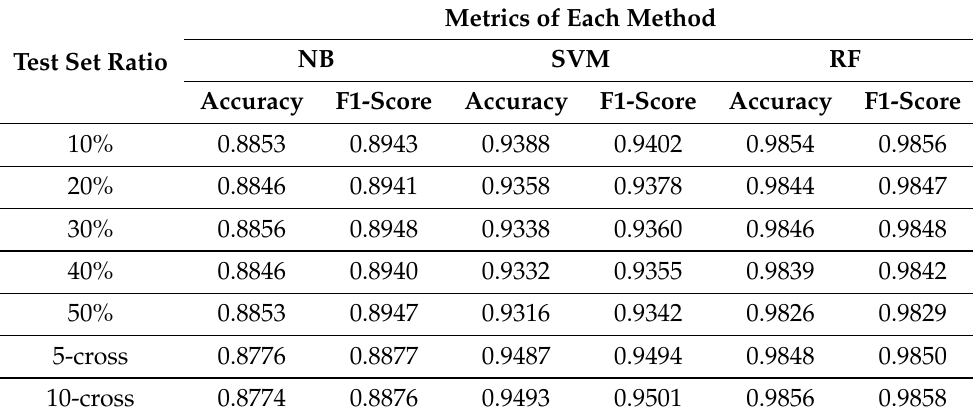
Table 5. Detection results with different algorithms and test set